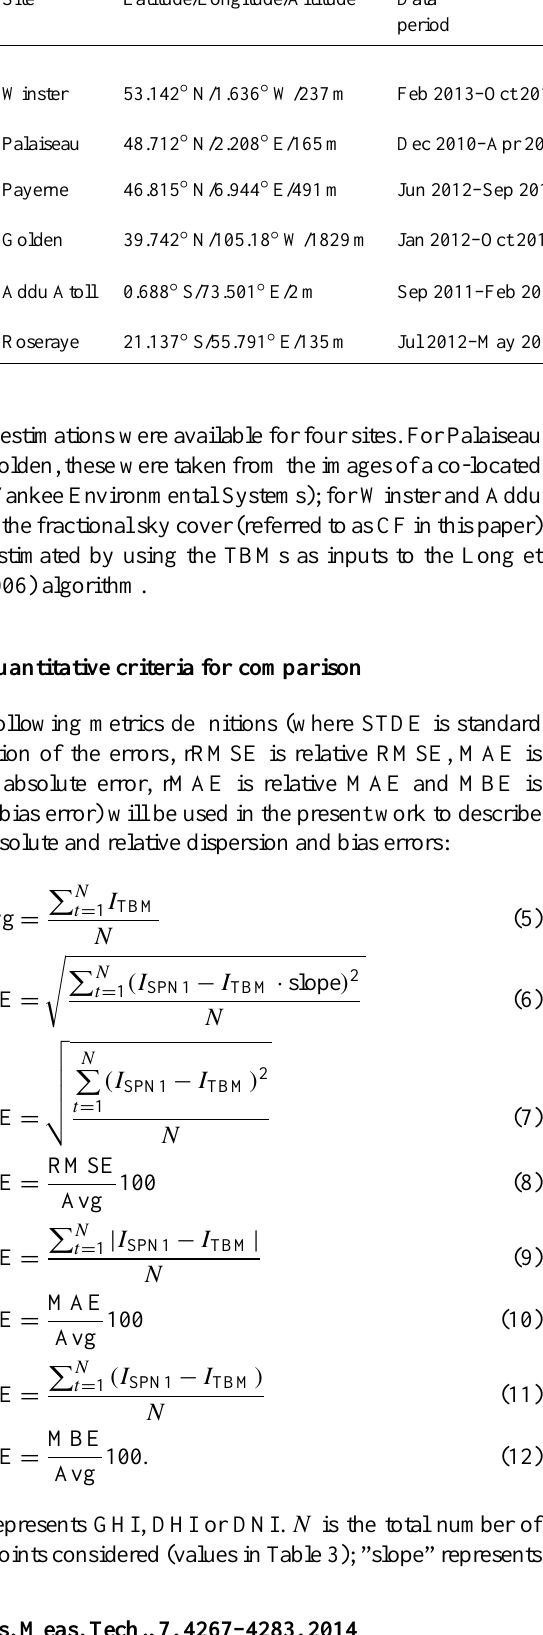
Table 2. Sites, data periods and instrumental information. Site Table!2:!Sites,!data!periods!and!instrumental!information! 720!